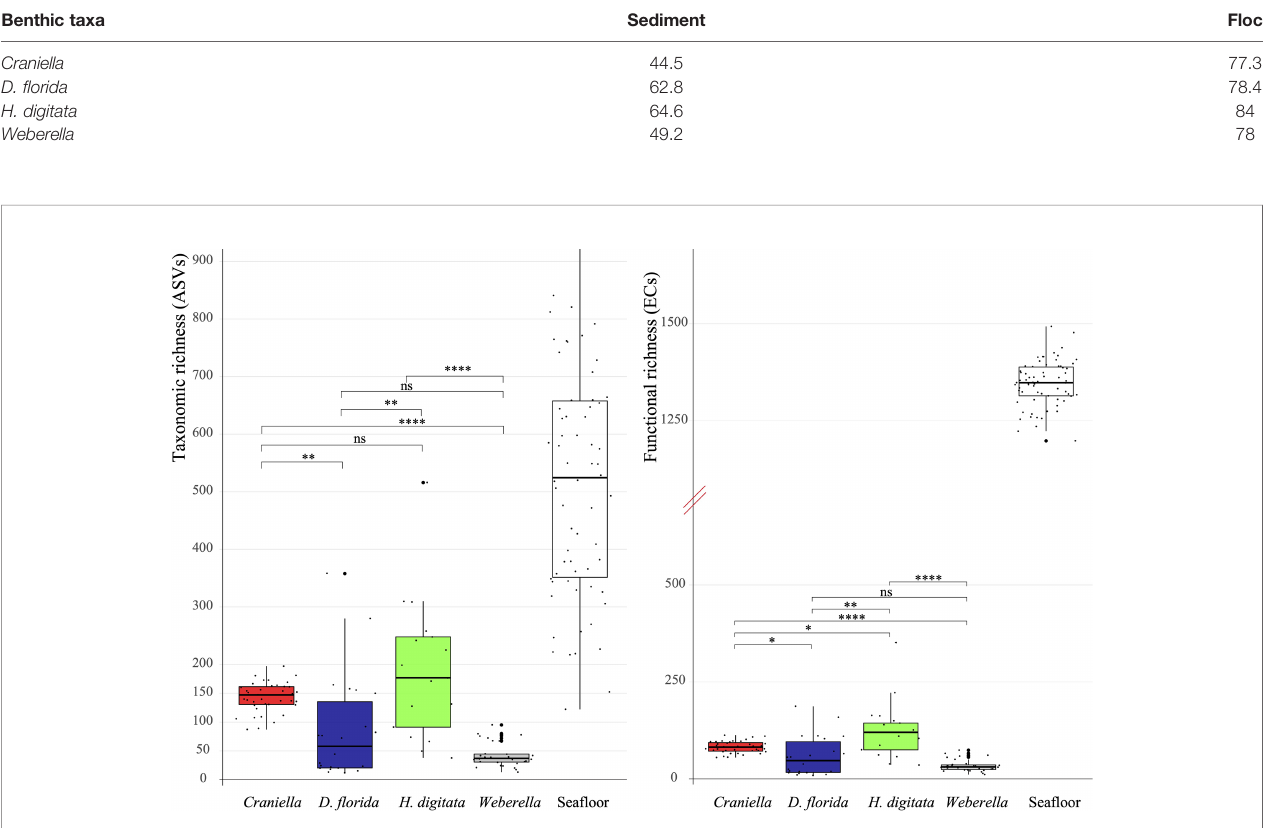
TABLE 2 | Mean percent of shared bacterial genera between epibenthic macrofaunal taxa with sediment and fl oc samples. Benthic